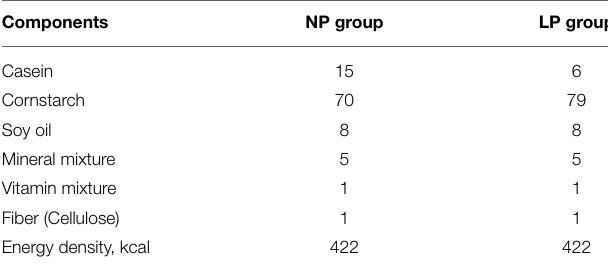
TABLE 1 | Composition (g/100g of diet) of both control and low protein diets (Tropia et al., 2001; Bezerra et al.,